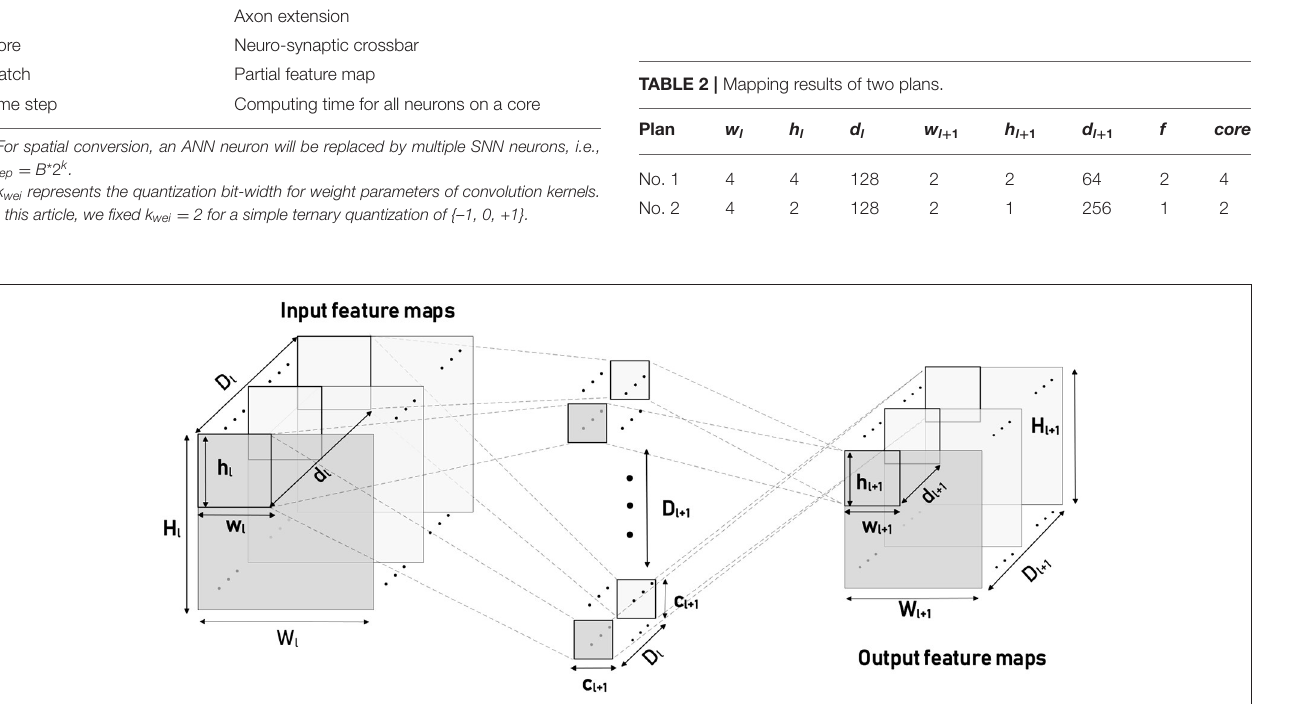
FIGURE 5 | Input and output patches on the corresponding feature